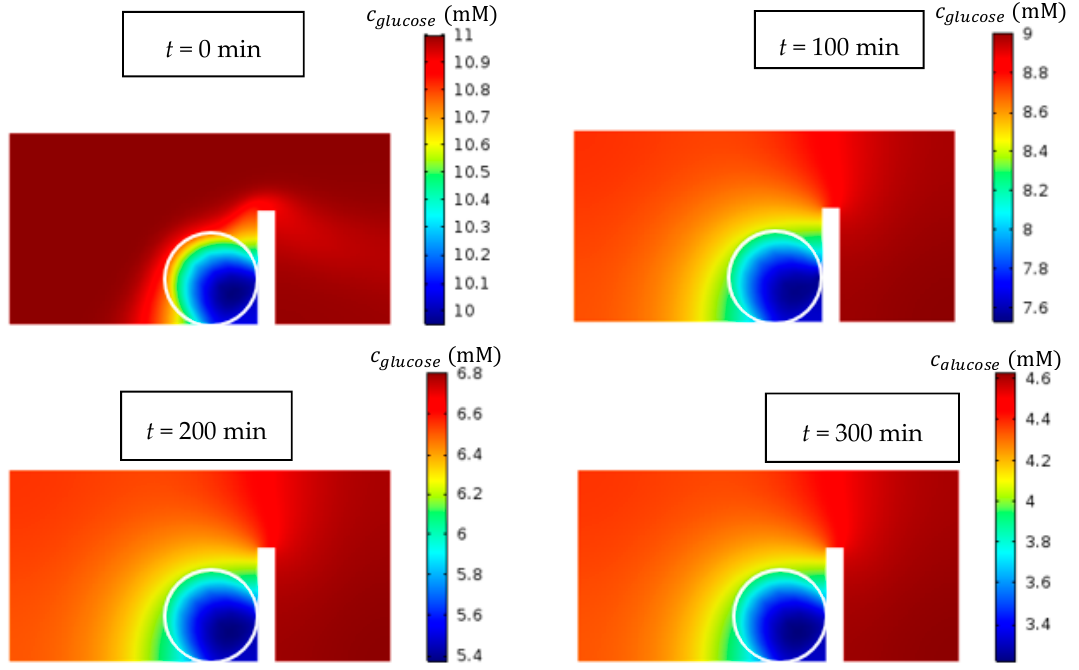
Figure 12. Glucose concentration contour at different times in the middle x – z plane inside and outside of the spheroid (color bar is in mM). Over the time, the possibility of necrosis increases. The simulations were carried out for Q initial = 5 µ L/min, D = 500 µ m and c 0. glucose = 11